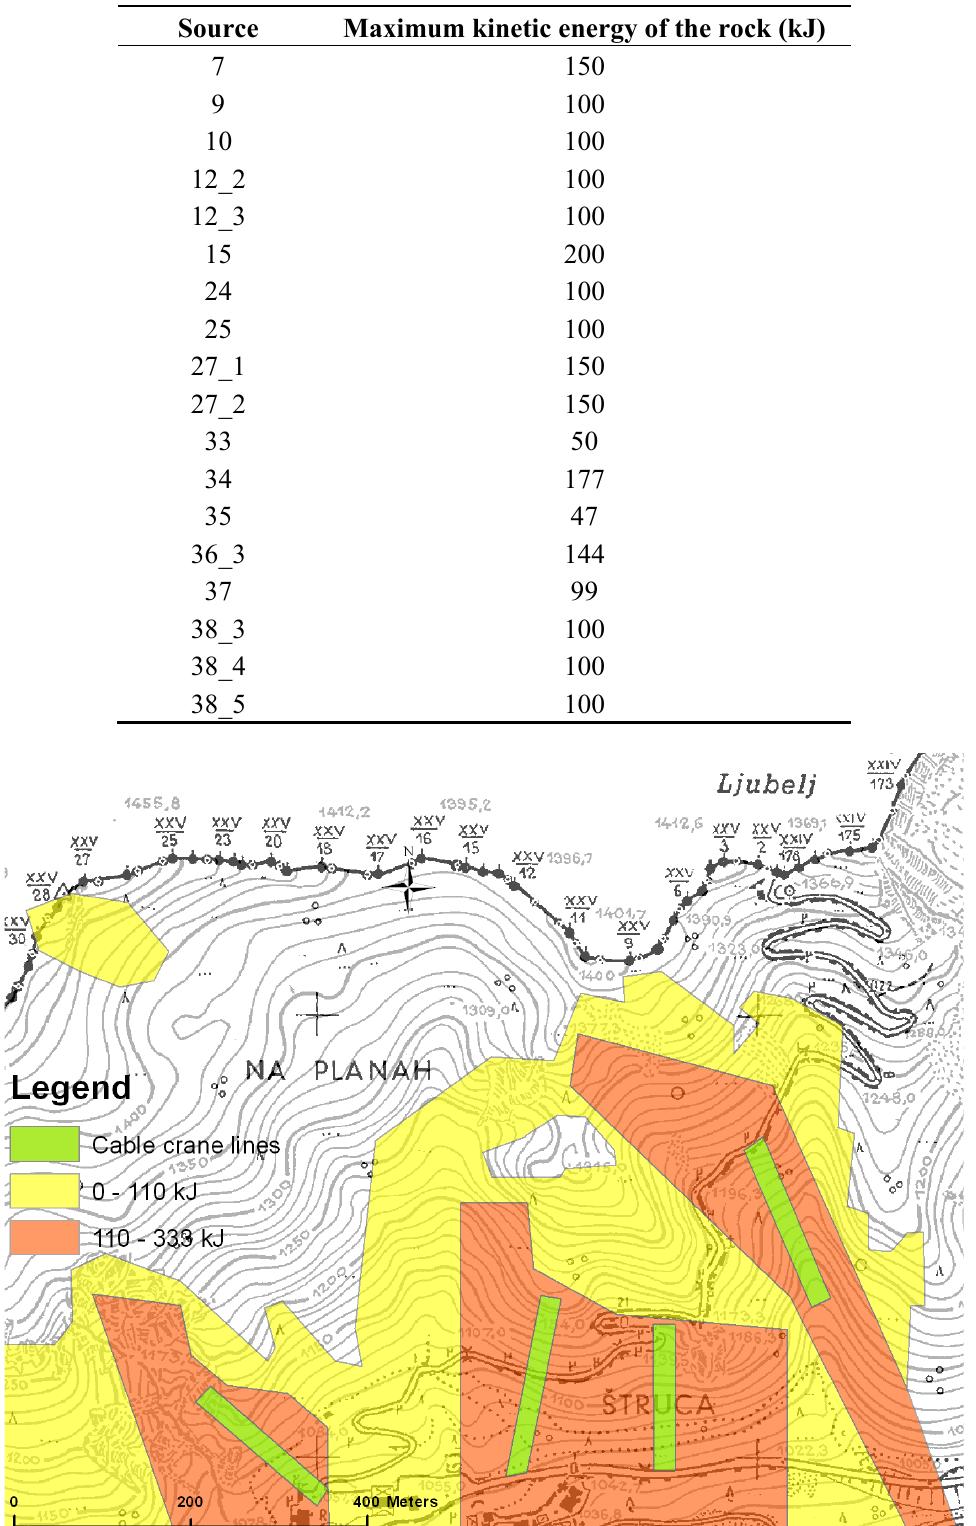
Figure A2. Three susceptibility areas delimited according to Rockyfor3D mean kinetic energy results for non-forested slope. Imaginary cable crane corridors used for Rockyfor3D simulations are coloured